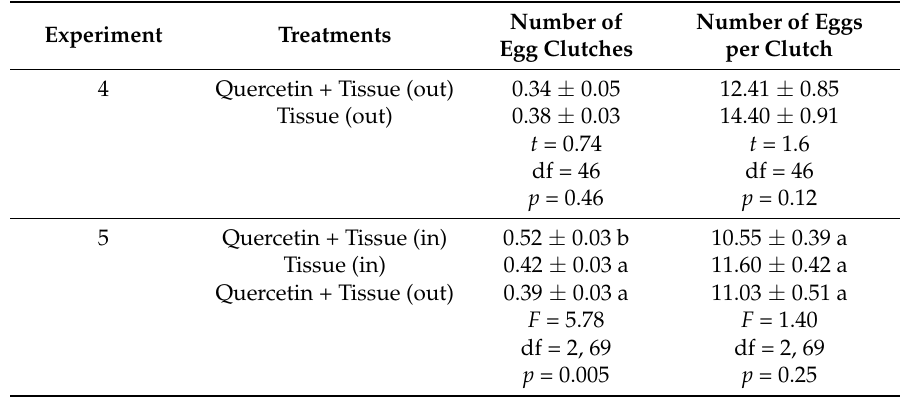
Table 4. Mean ( ± SE) number of egg clutches per C . maculata female per day and mean ( ± SE) number of eggs per clutch, regardless of site selection in communal 1